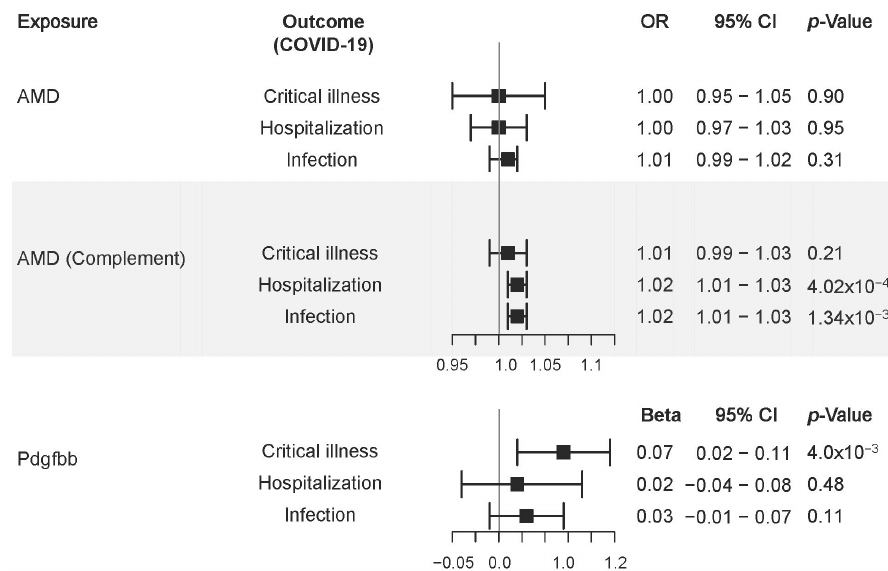
Figure 3. Forest plot illustrating the Mendelian randomization estimates of genetic liability of AMD risk, liability of AMD risk based on genes in the complement pathway, and human serum PDGF-BB levels (exposures) with COVID-19 phenotypes (outcomes) based on inverse-variance weighted Mendelian randomization.